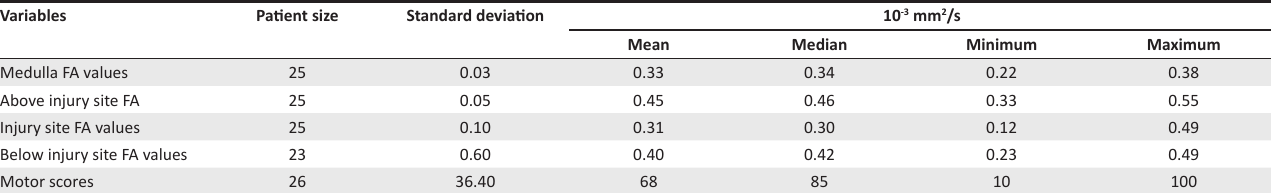
TABLE 1 : Cervical region diffusion tensor imaging fractional anisotropy values.